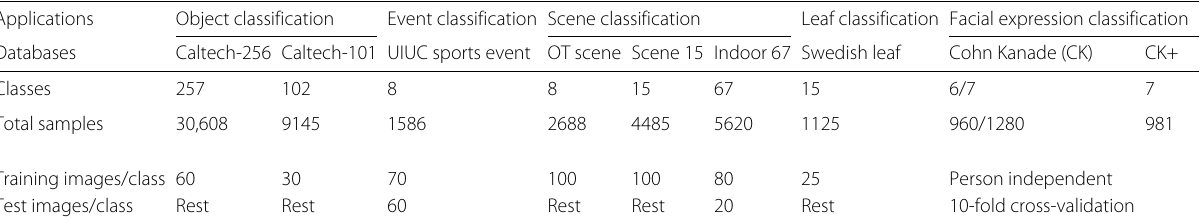
Table 1 Different benchmark datasets with proper training samples